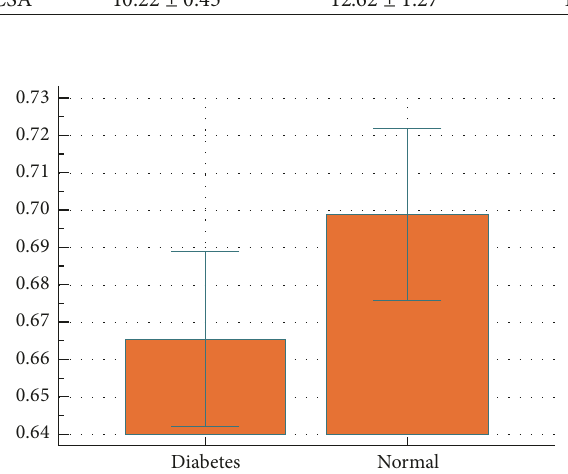
Figure 4: Data comparison graph for FNR in subjects with diabetic neuropathy (indicated with “diabetes”) and controls (indicated with “normal”). There is a significant difference between the two populations. For more details see Table